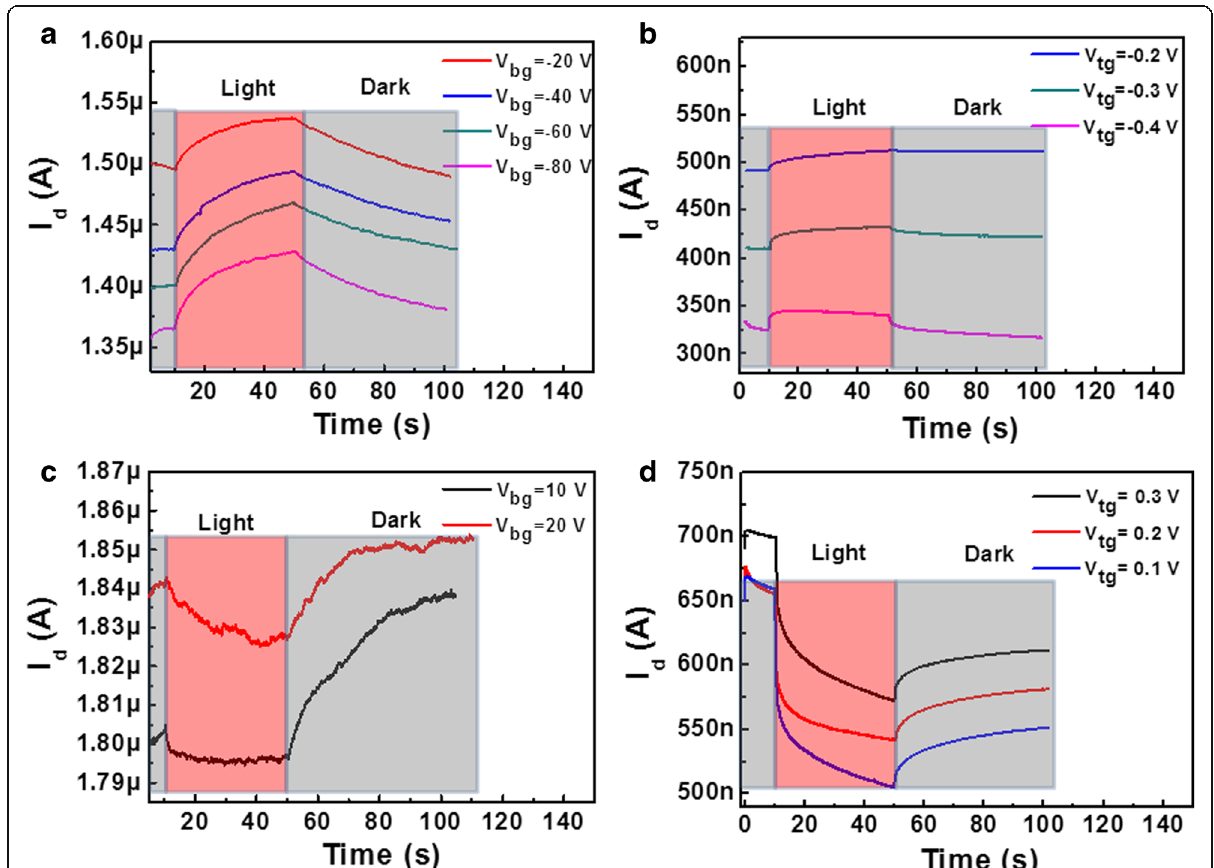
Fig. 3 Time dependence of the photoresponse of SnSe 2 FET biased at V sd = 5 mV when applied at different negative back gating voltages V bg ( a ), negative top gating voltages V tg ( b ), positive back gating voltages V bg ( c ), and positive top gating voltages V tg ( d